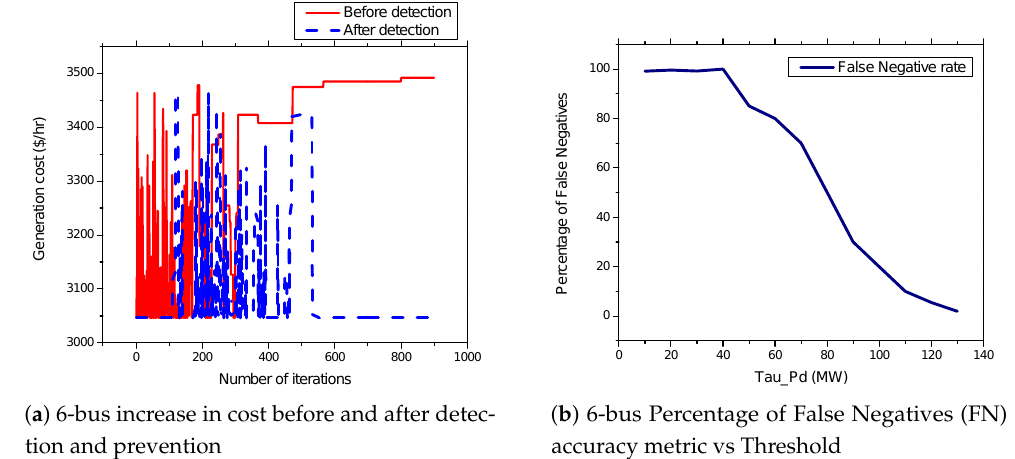
Figure 9. 6-bus systems increase in cost before and after detection and prevention and percentage of False Negatives (FN) accuracy metric vs. Threshold.